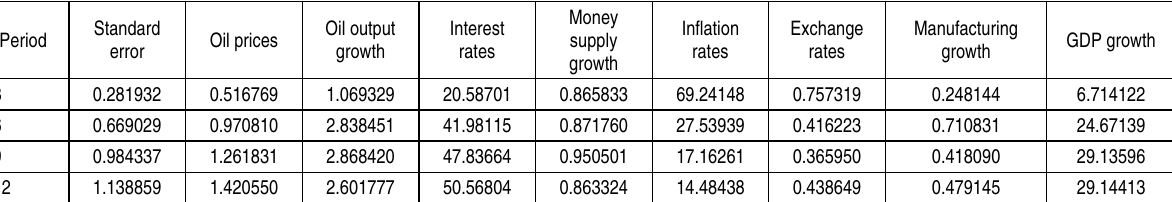
Table 3. Variance decomposition of inflation rate